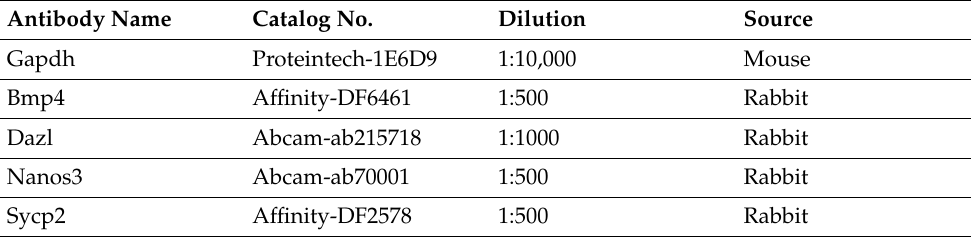
Table 2. The antibodies information for western